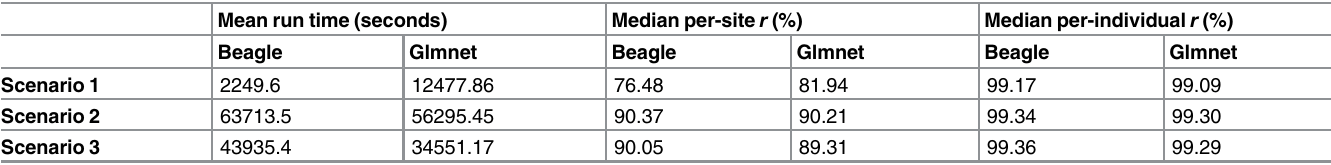
(Top) We calculated the mean computation time across the 10 folds of each cross-validation experiment. (Middle) We calculated the median r across sites and reported this as a scalar summary of imputation accuracy in that cross-validation experiment. (Bottom) We calculated the median r across individuals and reported this as a scalar summary of imputation accuracy in that cross-validation